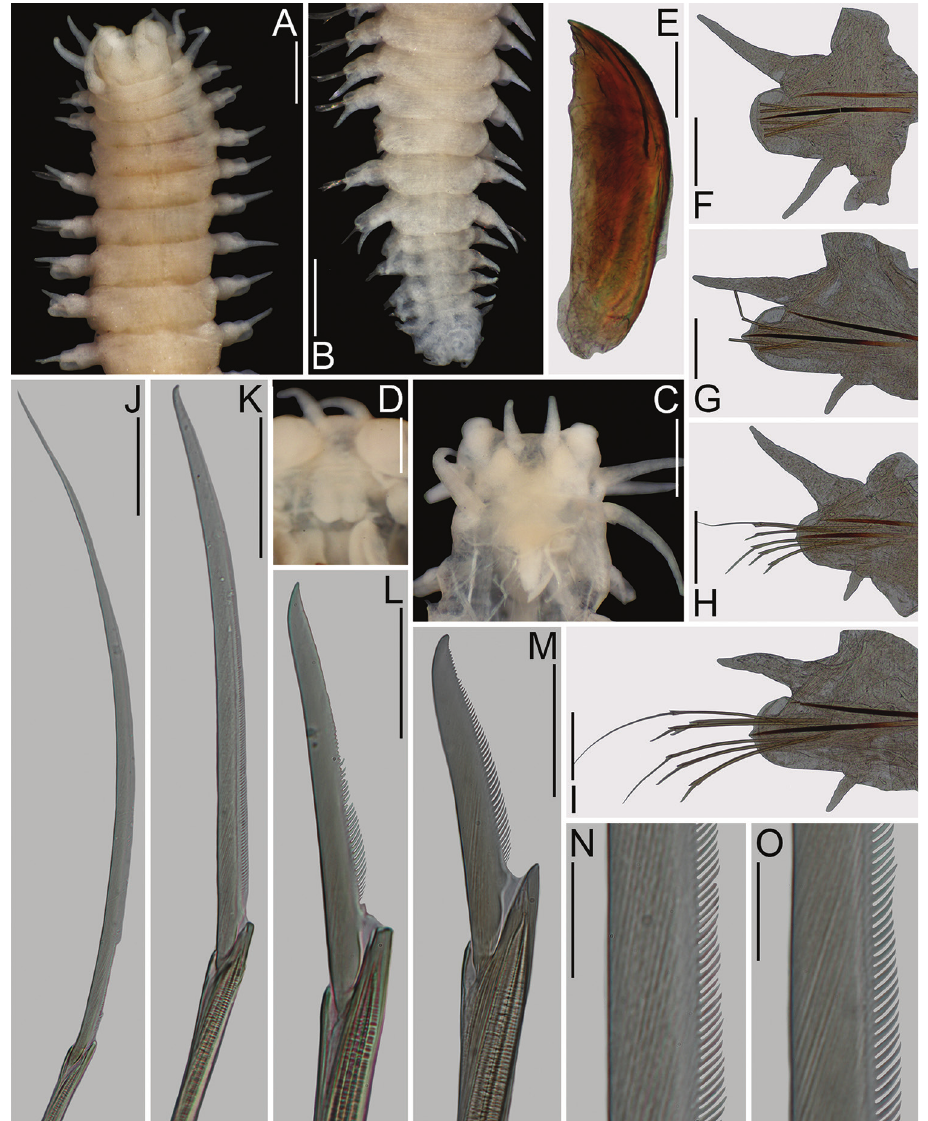
Figure 2. Namanereis christopheri sp. n. A, B, F–O Holotype LACM-AHF 1227 C–E paratype LACM- AHF 1229 A Anterior end, dorsal view B Posterior end, dorsal view C Close-up of prostomium D Areas V and VI, pharynx dissected E Right jaw, dorsal view F Chaetiger 5, right parapodium G Chaetiger 21, right parapodium H Chaetiger 49, right parapodium I Chaetiger 90, right parapodium J Supra-acicular sesquigomph spiniger, chaetiger 49 K Sub-acicular heterogomph falciger, chaetiger 49 L Supra-acicular heterogomph falciger, chaetiger 49 M Sub-acicular heterogomph falciger, chaetiger 49 N Close-up of blade, supra-acicular sesquigomph spiniger, chaetiger 49 O Close-up of blade, supra-acicular heterogom- ph falciger, chaetiger 49. Scale bars: 0.5 mm ( A–D ); 0.1 mm ( E ); 0.1 mm ( F–I ); 50 µm ( J , K ); 30 µm ( L , M ); 10 µm ( N , O